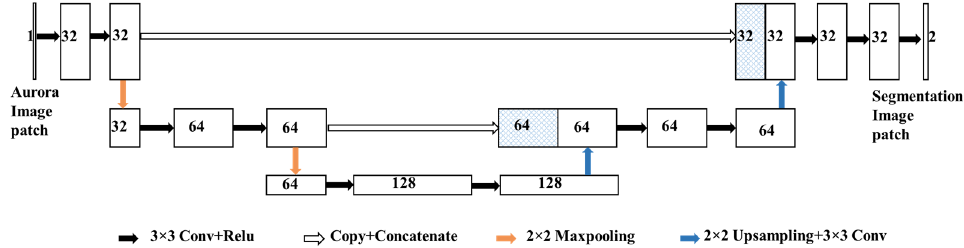
Figure 2. U-Net network architecture used in all-sky image segmentation.